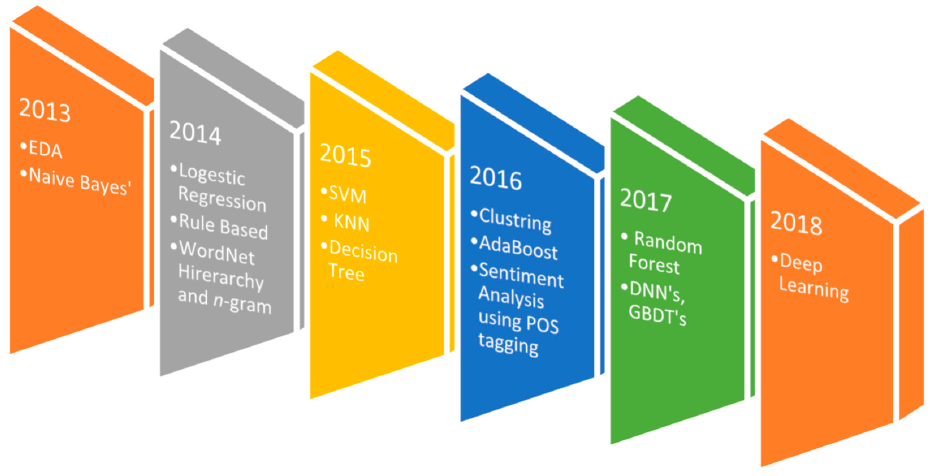
Figure 1. Machine learning techniques used for online radicalization and terrorist detection.